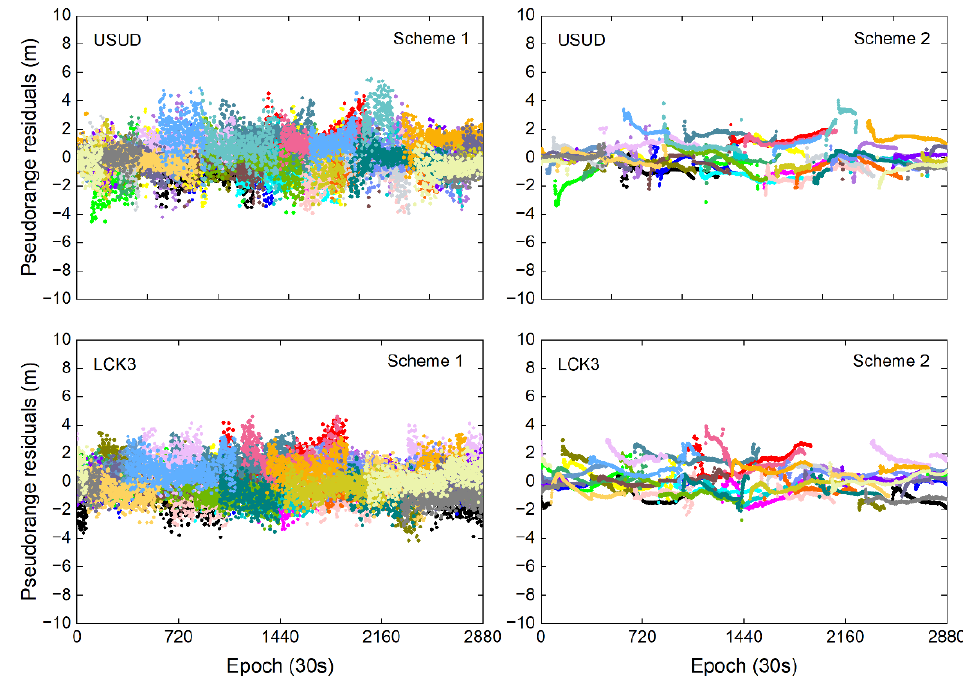
Figure 9. Pseudorange residuals of USUD and LCK3 stations with two schemes. Each color represents each satellite.